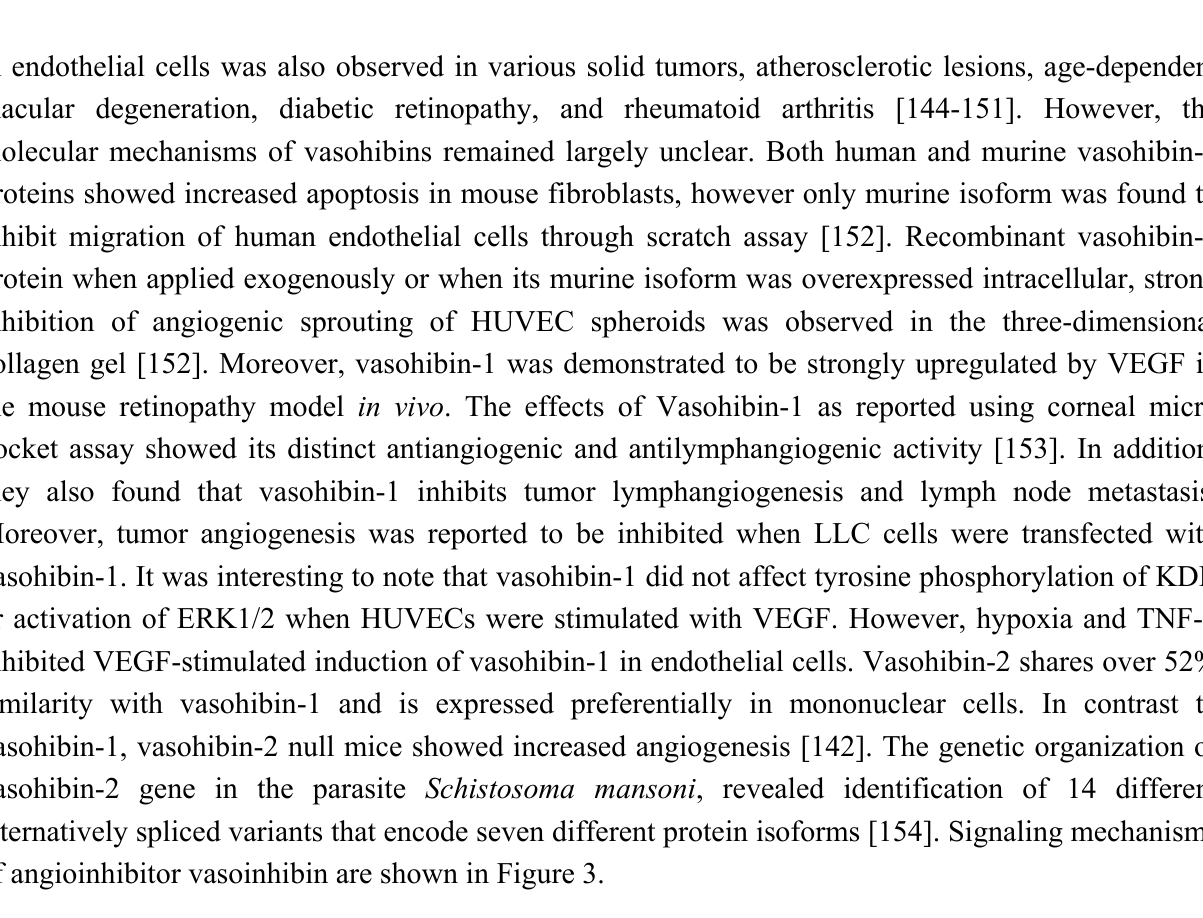
Figure 3. Illustration of vasoinhibin mediated angioinhibitory